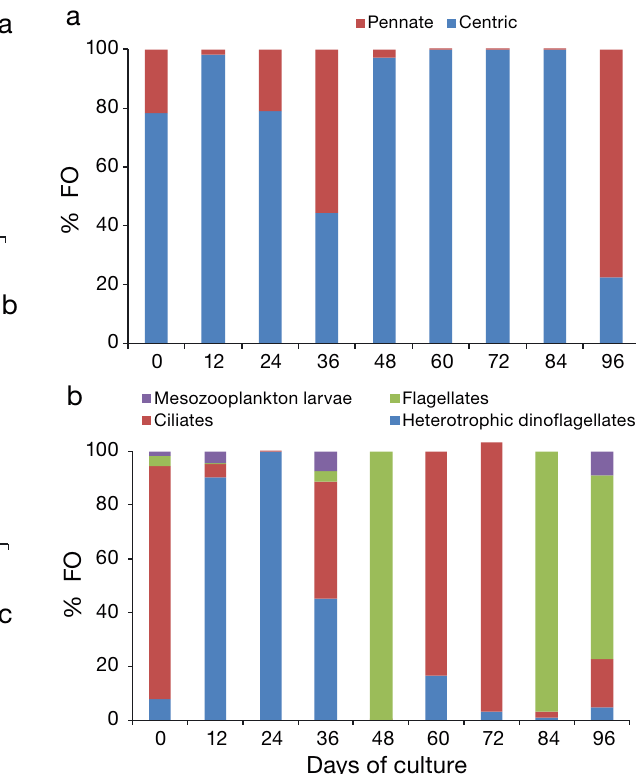
Fig. 3. Frequency of occurrence (%FO) of (a) diatom and (b) microzooplankton groups during the culture of